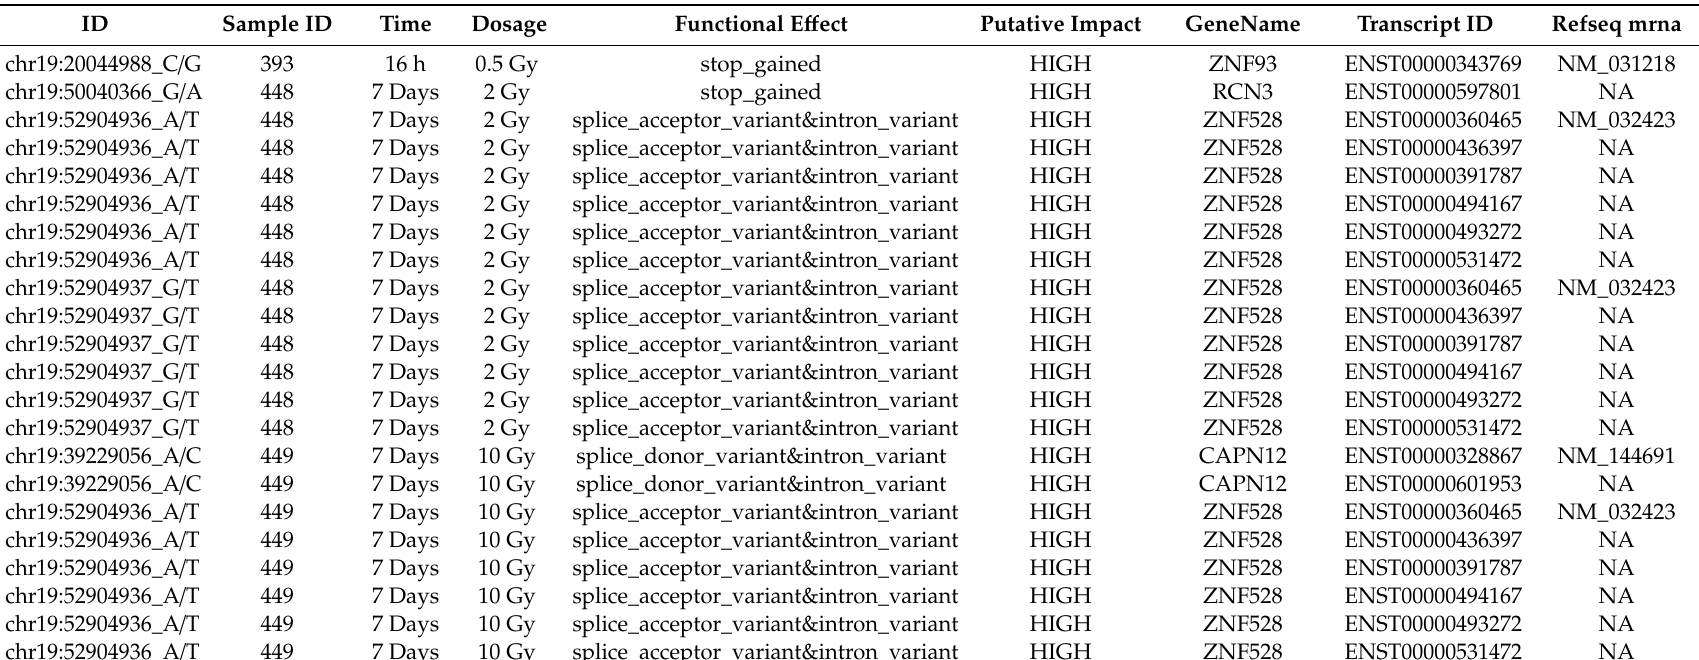
Table A1. Table reporting functional consequences for chromosome